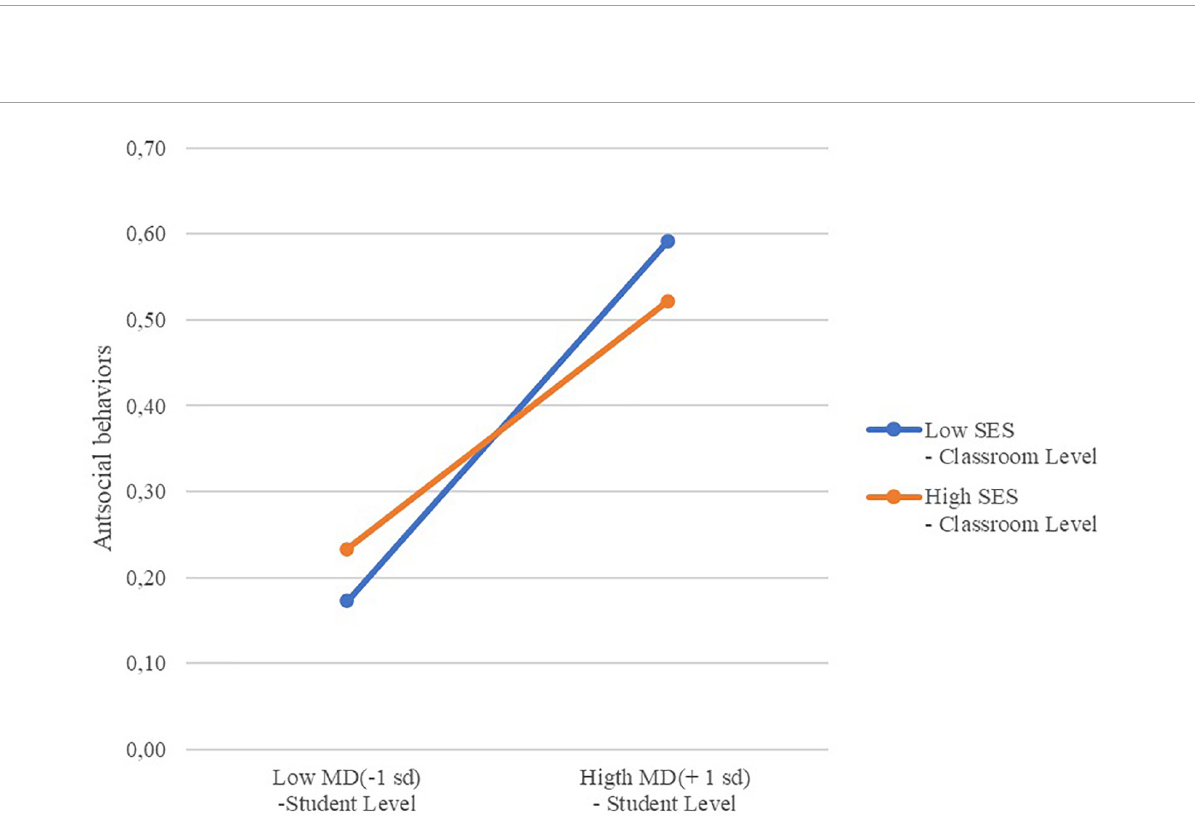
FIGURE3 Cross-level interaction effect of individual moral disengagement with classroom means SES on antisocial